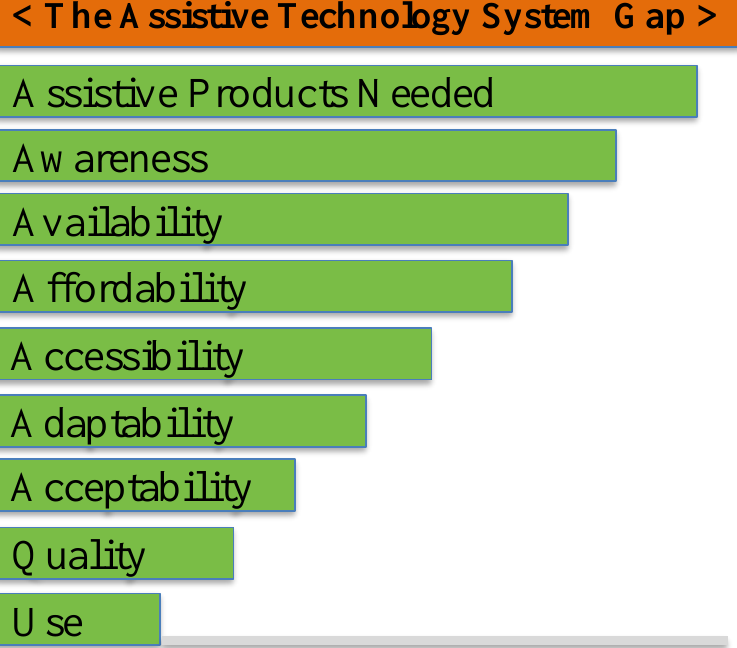
Figure 1. A schematic representation of the Assistive Technology System gap. Note: This bar chart is not to scale—globally the number of APs needed far exceeds those available, sometimes by a ratio of 10 or more to one, and this is patterned by socioeconomic factors, marginalization and so on. Reproduced with permission from MacLachlan et al.